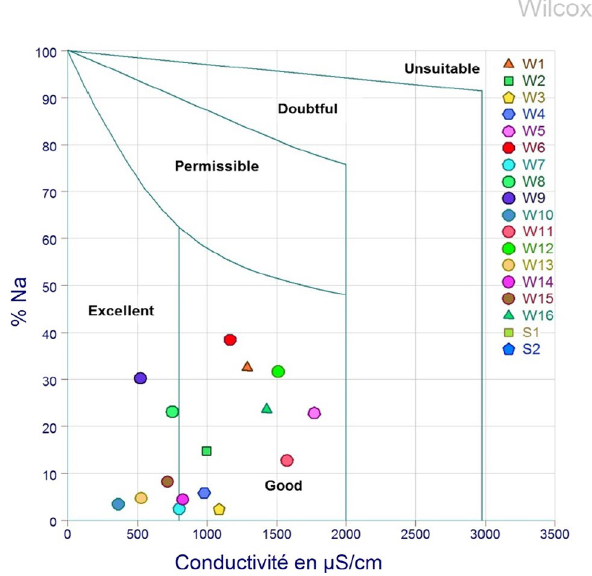
Fig. 7 Wilcox diagram for water samples from the Timahdite–Almis Guigou basin